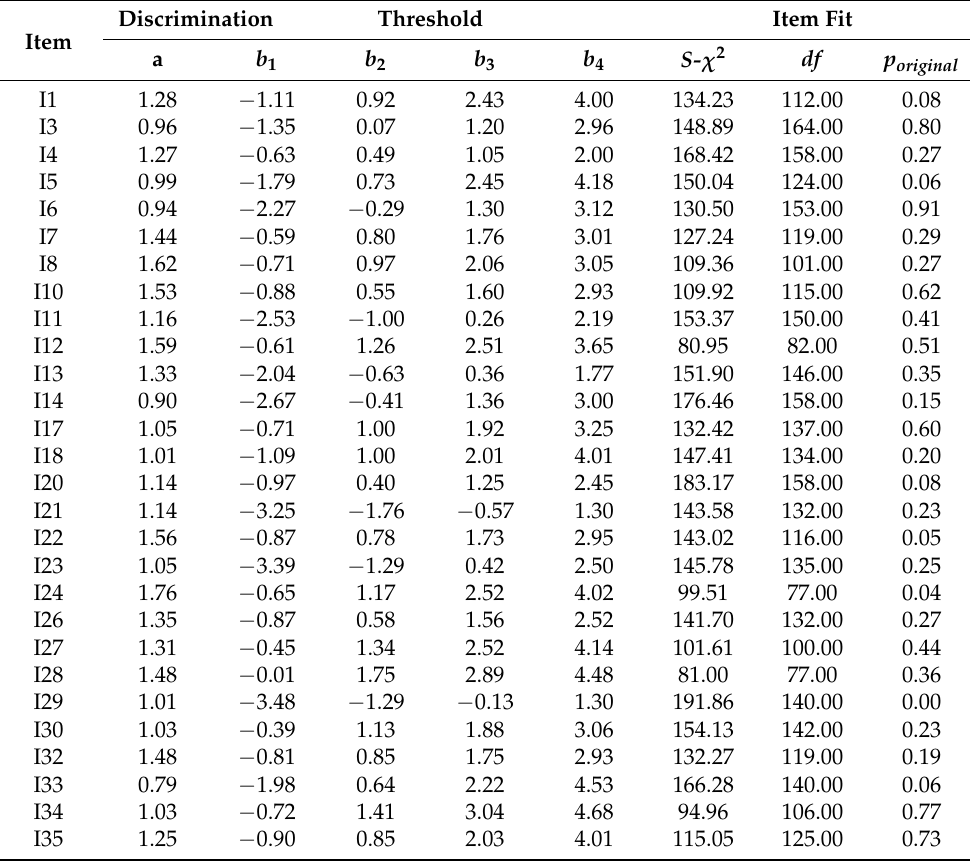
Table 5. Item fits and parameter estimates of the D28-C based on